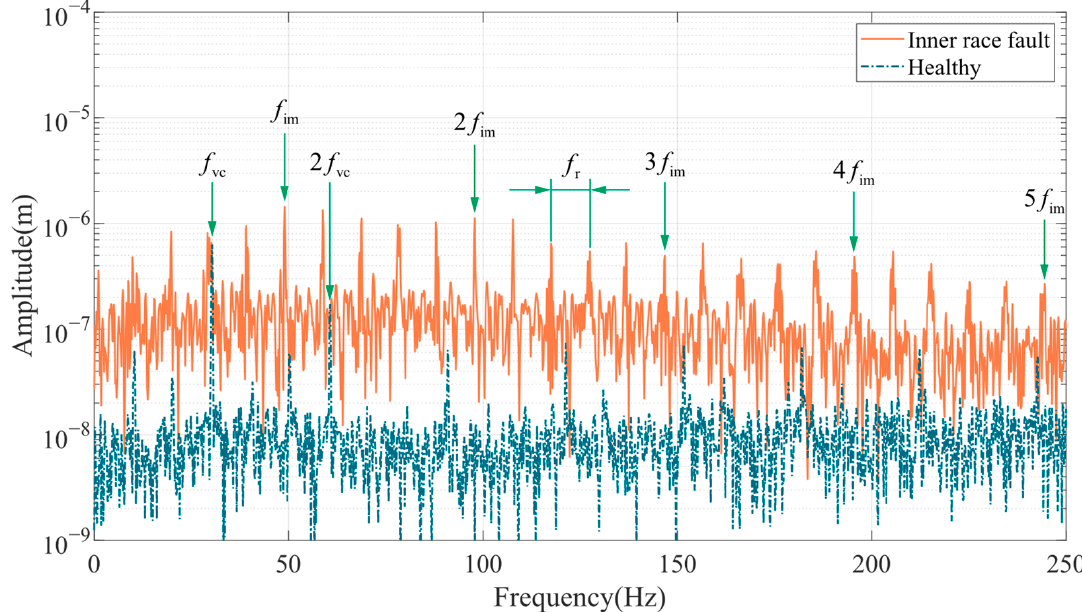
Figure 16. Comparison of rotor vibration spectrum in Y-direction under inner race fault (10 Hz).